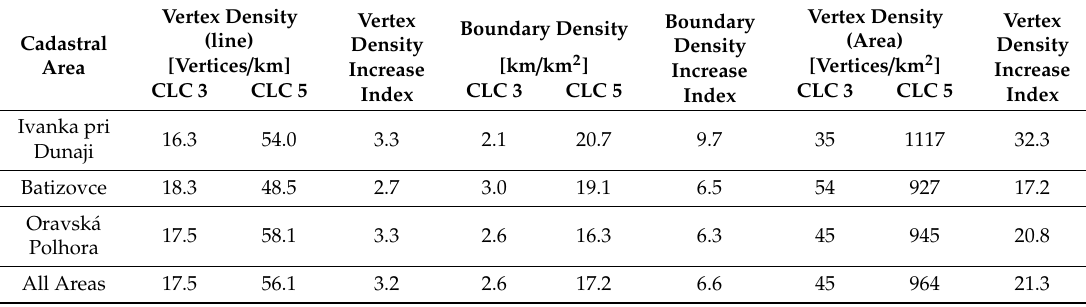
Table 6. The comparison of the spatial detail of the 3rd and 5th CLC level (CLC3 and CLC5) used in the cadastral